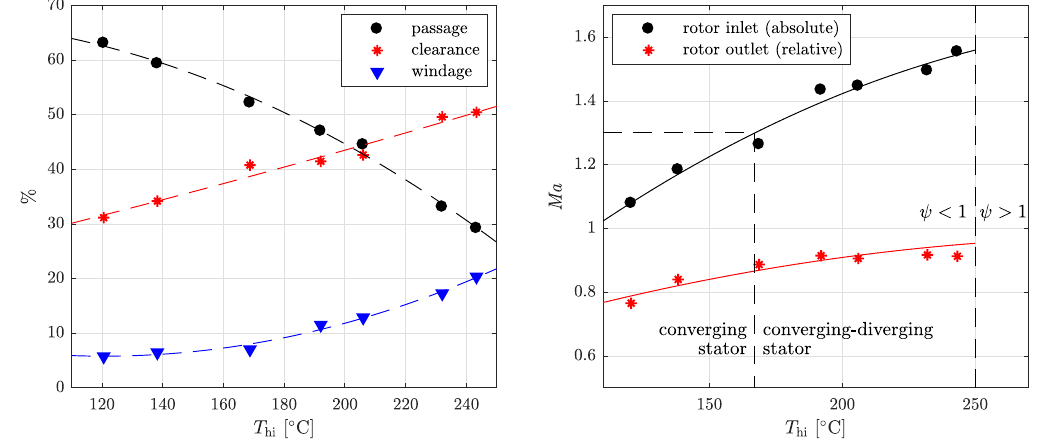
Figure 14. Breakdown of the passage, clearance and windage loss within the rotor ( left ) and variation in the rotor inlet absolute Mach number and rotor outlet relative Mach number ( right ) for the nine optimal turbine designs, plotted as a function of heat-source